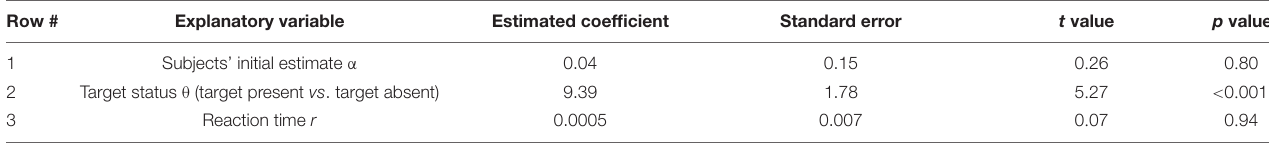
TABLE 4A | Contribution of the various explanatory variables to the final estimates γ when anchoring information was available in Experiment 2 (Conditions 3 and 4): Post hoc general linear modeling (GLM) of the contributions of the various explanatory variables to the response variable ( i.e ., final estimates γ of subjects).